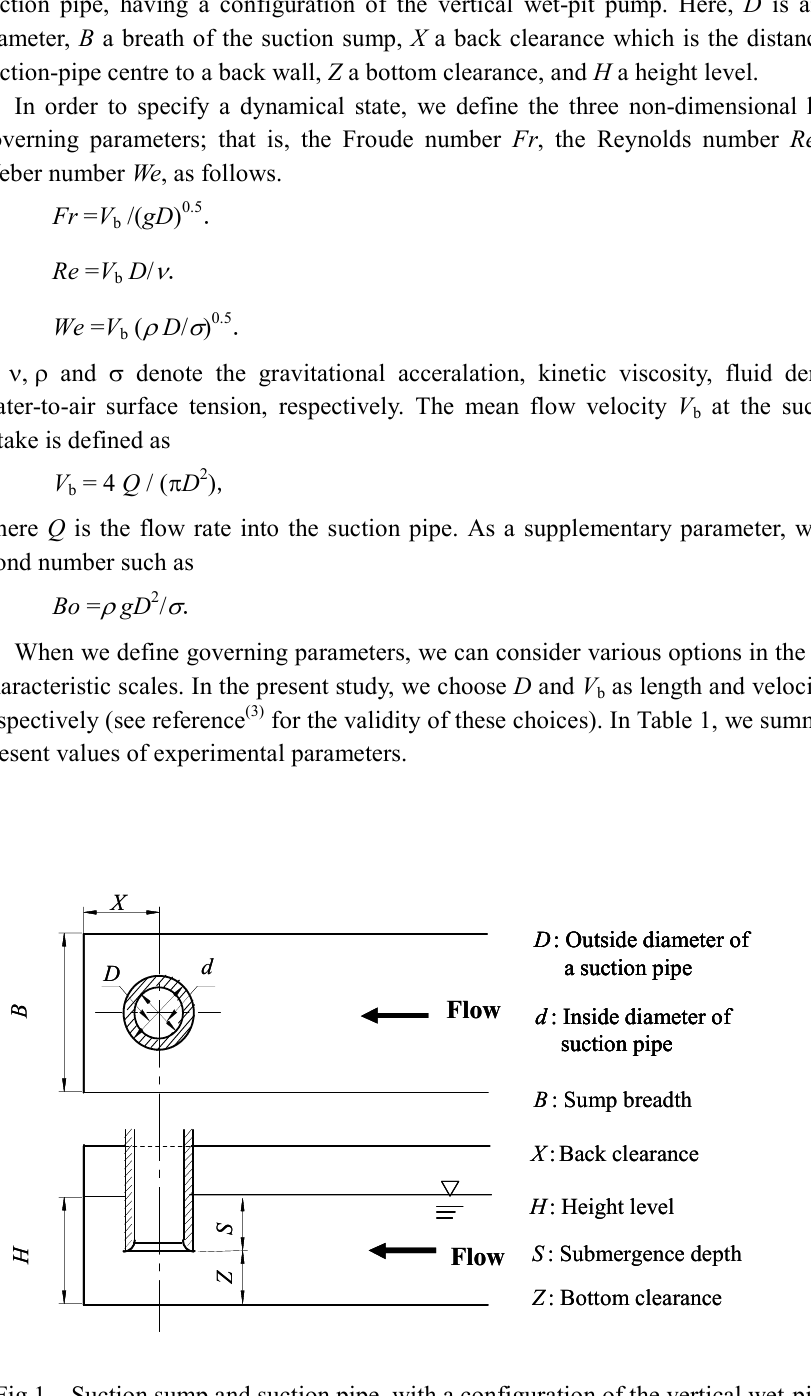
Fig.1 Suction sump and suction pipe, with a configuration of the vertical wet-pit